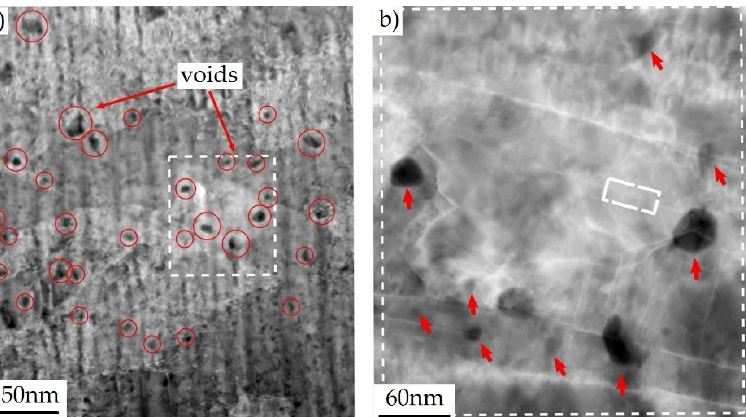
Figure 3. ( a ) HAADF-STEM image presenting nanoscale voids (black areas) in copper subjected to tension (plastic strain); ( b ) Enlargement of the boxed area in ( a ), from [20]. White rectangle in ( b ) indicates the twin